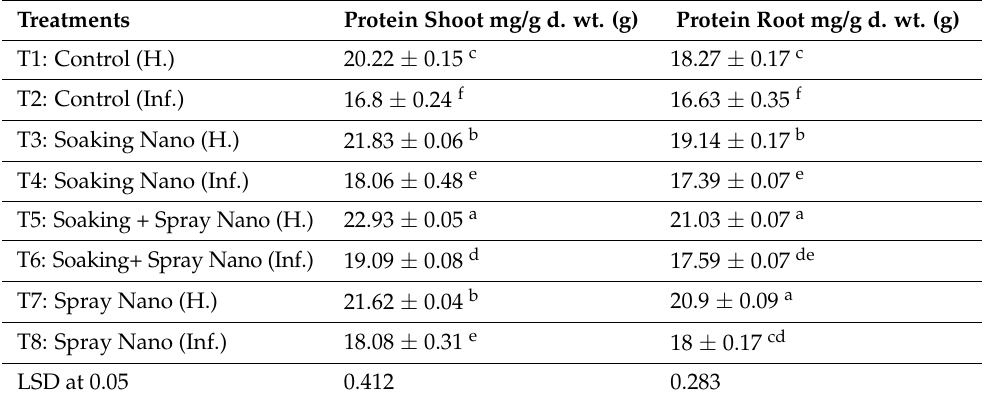
Table 5. Effect of Se-NPs on the total soluble protein of ( Vicia faba L.). Treatments